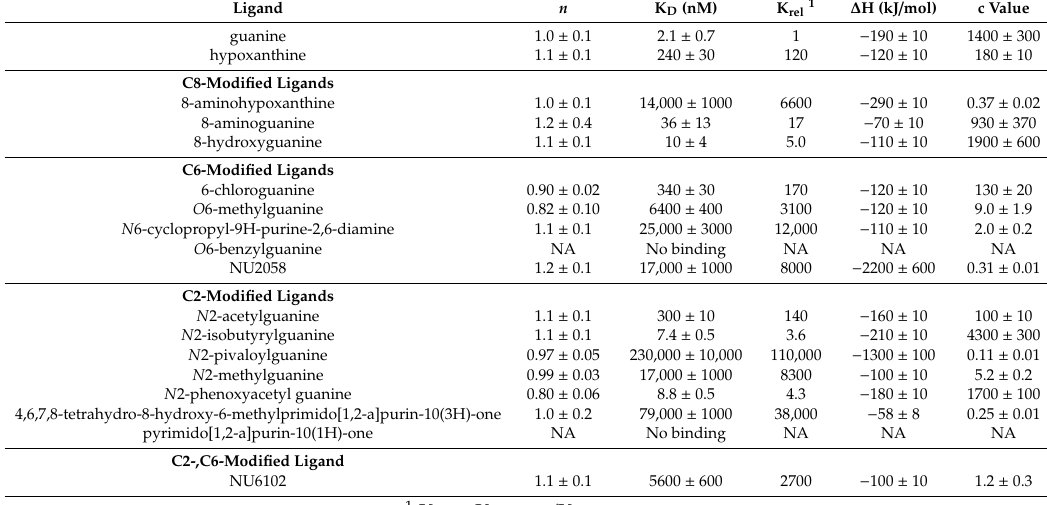
Table 1. Isothermal titration calorimetry (ITC) measurements of ligand binding to GR